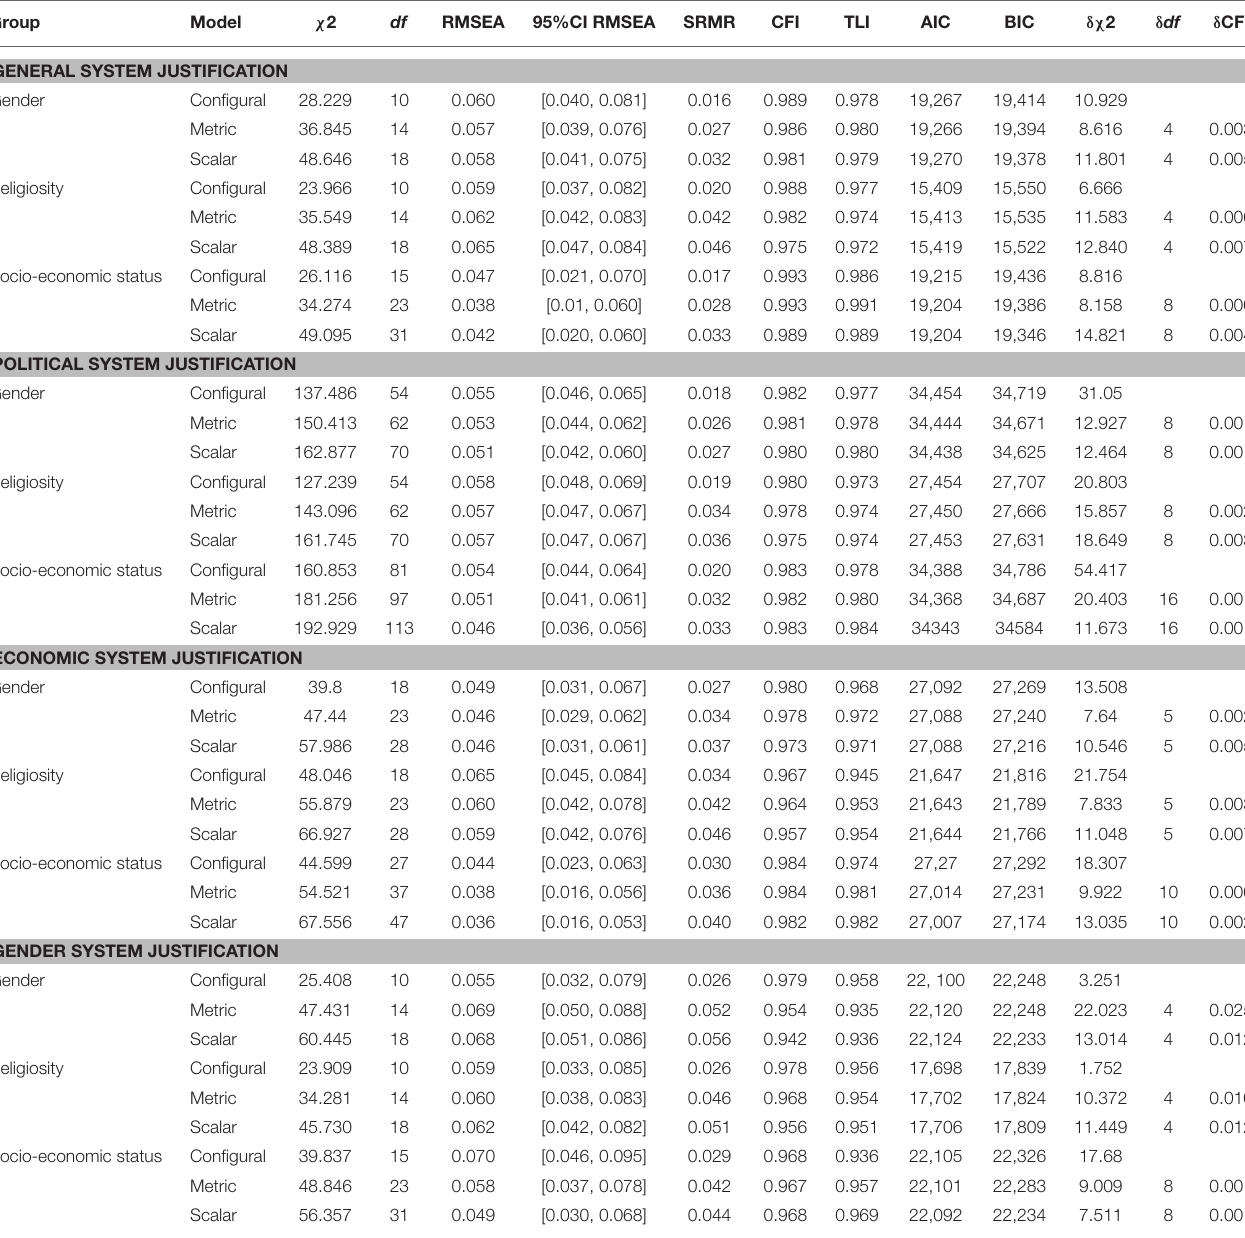
TABLE 6 | The results of the